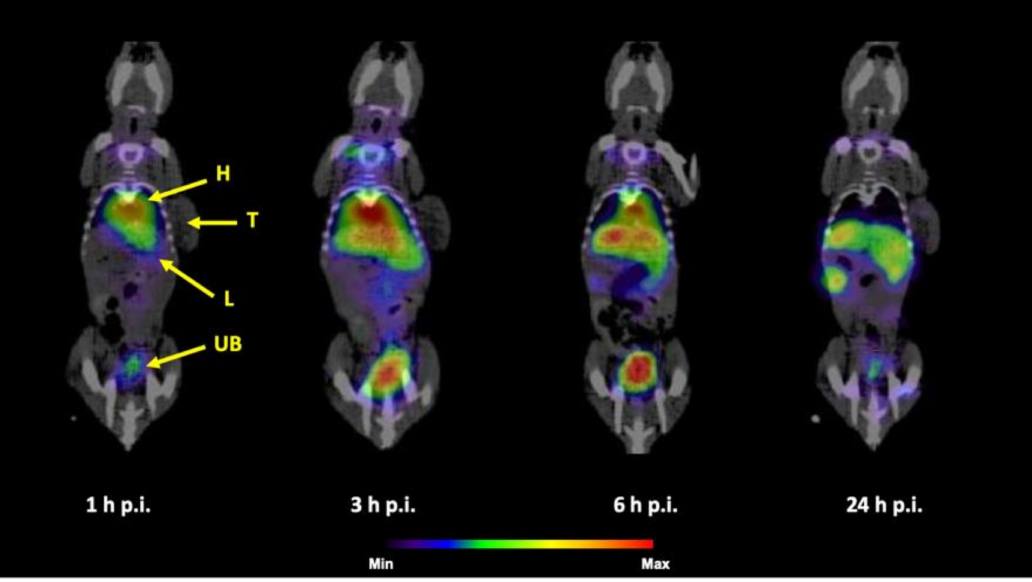
Figure 9. Coronal slices of SPECT / CT imaging of 99m Tc-PEG5000-HAP in HCT116 tumor-bearing mouse 1, 3, 6 and 24h p.i. after r.o. injection (H = heart, L = liver, T = tumor, UB = urinary